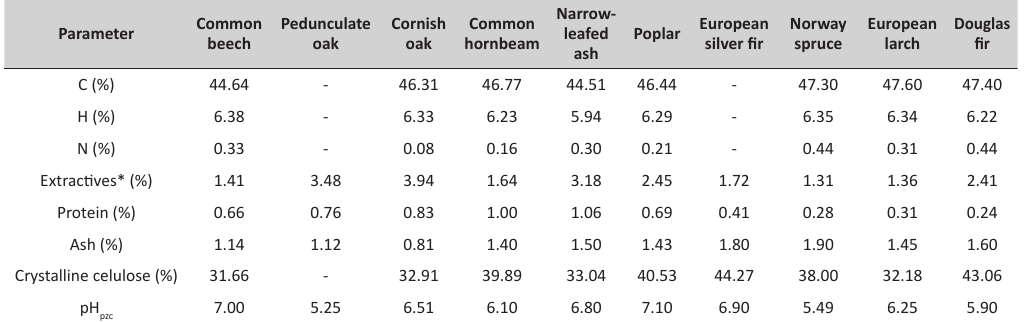
tABle 1. The chemical composition of waste wood